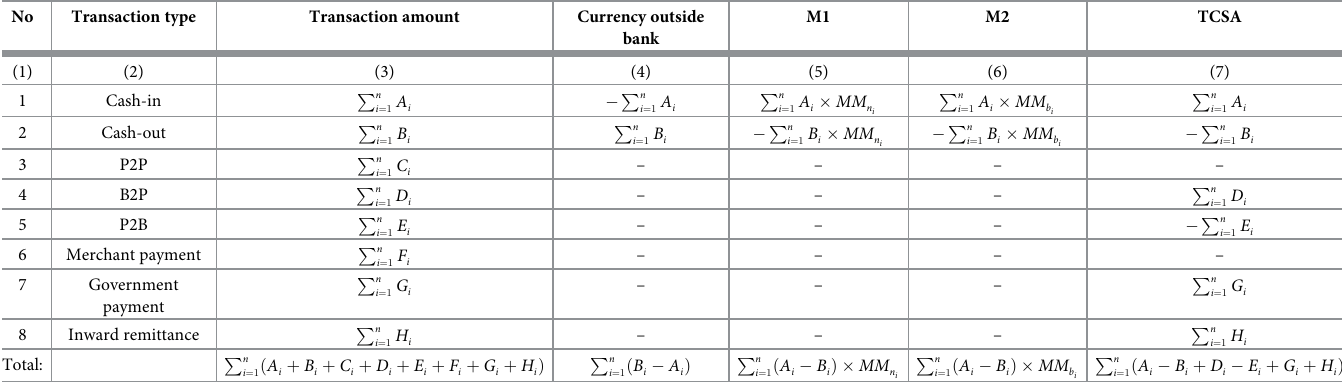
Table 3. Cumulative effect of MFS transactions on monetary aggregates over the